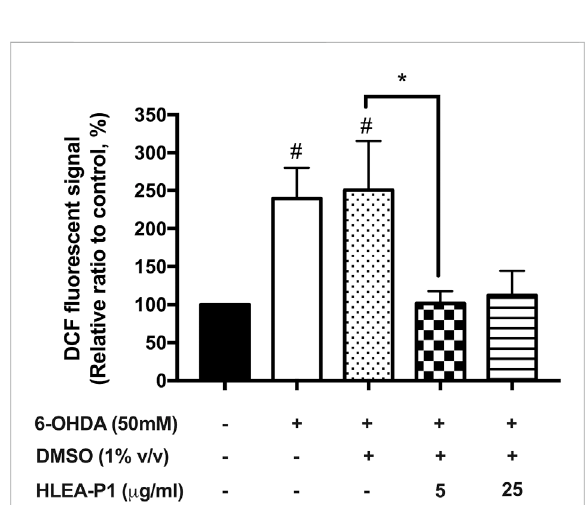
FIGURE 3 Effect of HLEA-P1 on reactive oxygen species in 6-OHDA- induced C. elegans PD model. Graphical representation for DCF fl uorescence (%) in normal, 6-OHDA-, 6-OHDA/DMSO-, and 6- OHDA/DMSOplusHLEA-P1-treated wormscomparedtothe untreated group. The data are presented as mean ± SEM (three independent replicates, n = 30 number of animals per replicate). The hash (#) indicates a signi fi cant difference between untreated and 6-OHDA-, 6-OHDA/DMSO-treated worms. The asterisk (*) indicates signi fi cant differences between 6-OHDA-, 6-OHDA/ DMSO- and HLEA-P1-treated groups at p <